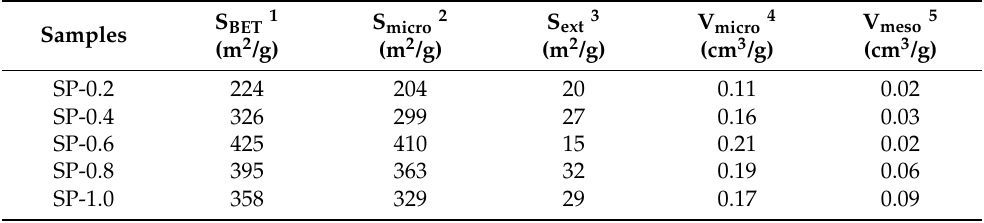
Table 2. Textural properties of as-synthesized